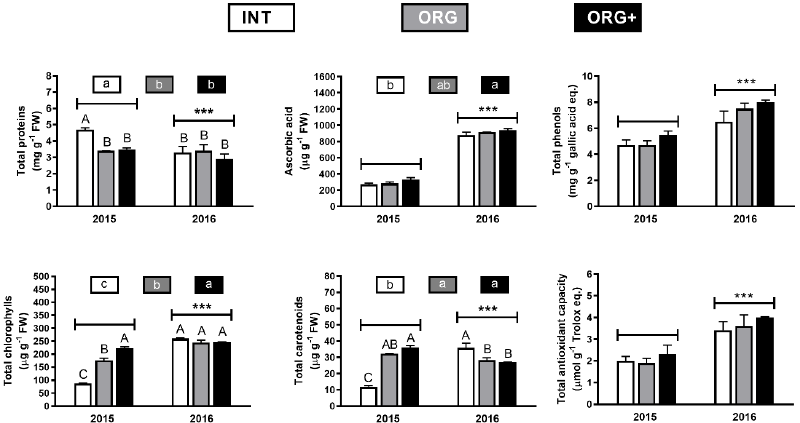
Figure 3. Totalproteins,ascorbicacid,totalphenols,totalchlorophylls,totalcarotenoids,andtotalantioxidant activity of savoy cabbage cultivated according to three different cropping system: integrated (INT), organic farming (ORG), and organic no-tillage (ORG + ) in a two-year experiment. Each value is the mean ± SD of three replicates. Means keyed with the same capital letter are not significantly different for p = 0.05 following two-way ANOVA using production year (2015–2016) and the three different cropping systems (INT, ORG, and ORG + ) as the variability factors. When the F ratio in the two-way ANOVA interaction was not found significant, data were analyzed by one-way ANOVA using year of cultivation or cultivation systems (considering the average of two years of production) as the variability factor. The presence of asterisks denotes significant differences for p < 0.05 following one-way ANOVA using production year as the variability factor (*** p < 0.001), whilst the presence of different lowercase letters denotes significant differences for p < 0.05 following one-way ANOVA using cropping systems as the variability